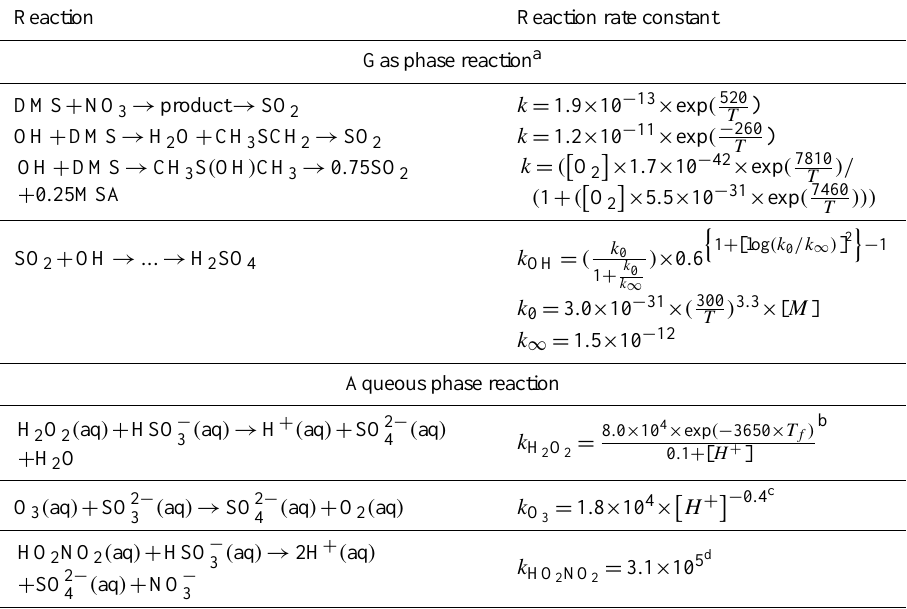
Table 1. Gaseous- and aqueous-phase reactions considered in the sulfur cycle. Reaction Reaction rate constant